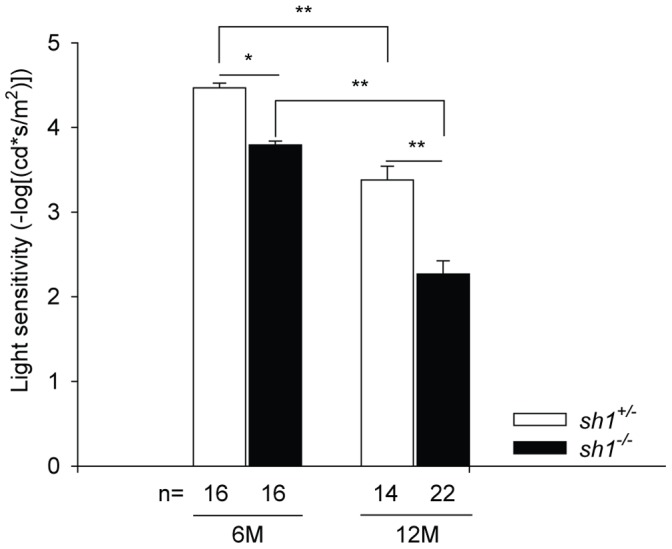
Retinal light sensitivity of albino sh1 mice. The minimum light intensity (inverted log scale) at which a b-wave shaped response is elicited is shown. Data are presented as mean±SEM, n indicates the number of eyes analyzed, M: months. *p value<0.05, **p value<0.001. More details on the statistical analysis including specific statistical values can be found in the Statistical analysis paragraph of the Materials and Methods section.